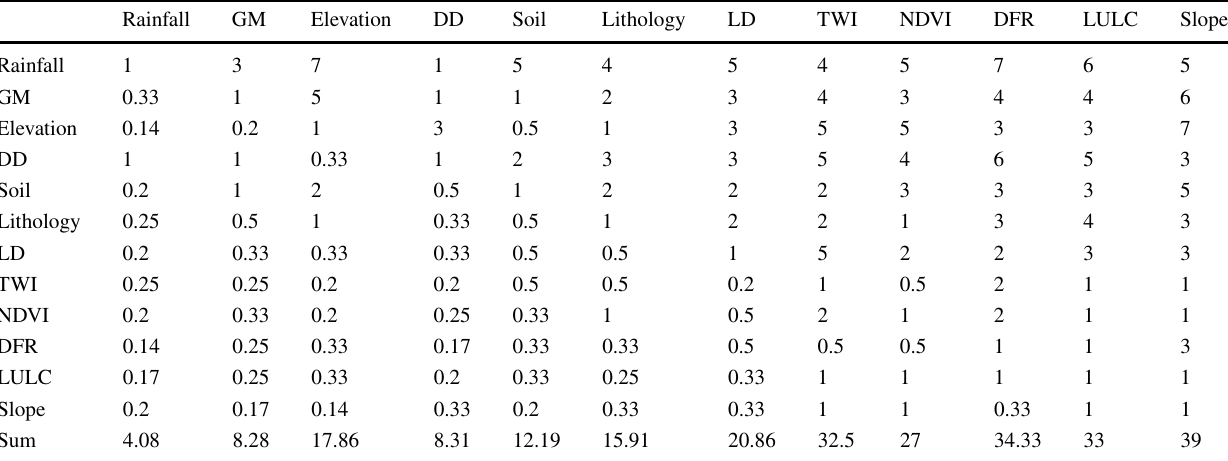
Table 4 Pairwise comparison